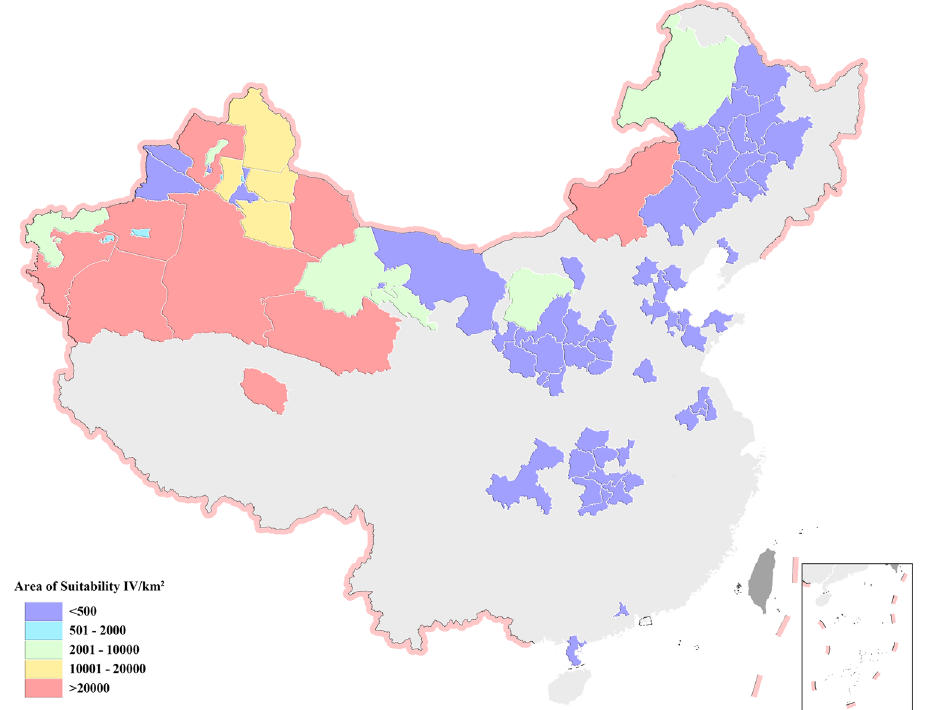
Figure 9. Mapping of areas classified as environmentally suitable for CO 2 capture and storage as class IV in China’s prefecture-level regions. Four categories of suitability for CO 2 geological storage include I and II, III and IV with increasing suitability. The map in this figure were generated by software ArcGIS 9.2 (http:// www.esri.com/arcgis/about-arcgis) based on our own data. The China spatial boundary GIS data is from